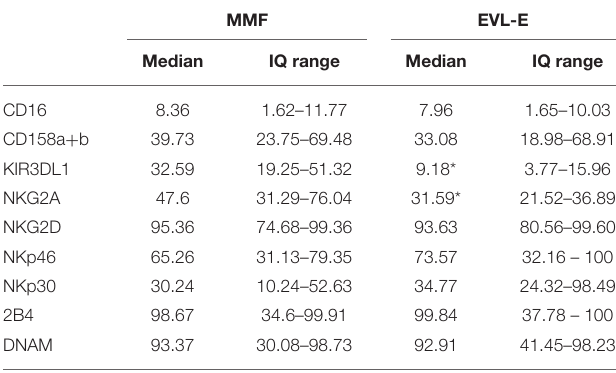
TABLE 2 | Expression of NK cell receptors in HT patients from the prospective